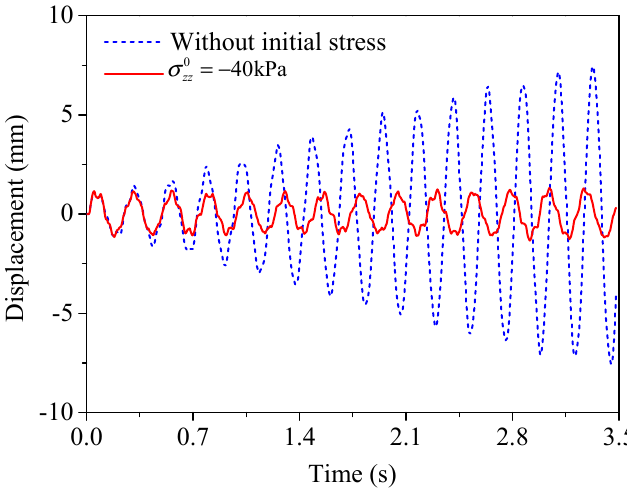
Figure 11. Averaged dynamic responses of the top edge of the periodic foundation under SV wave with f = 4.3 Hz.